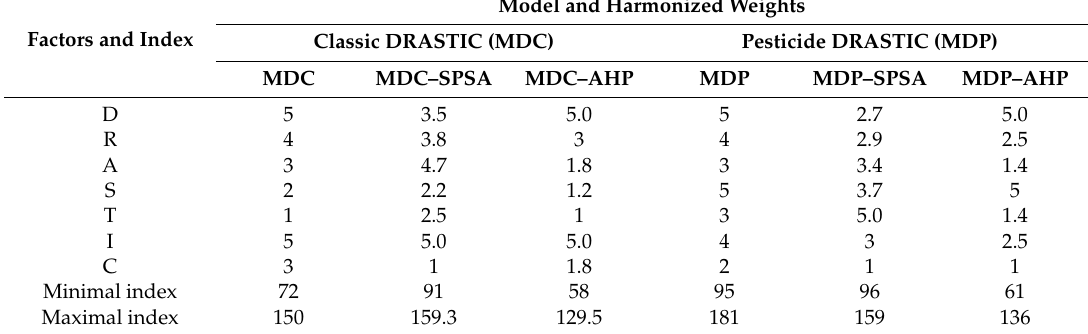
Table 8. Models and harmonized weights.